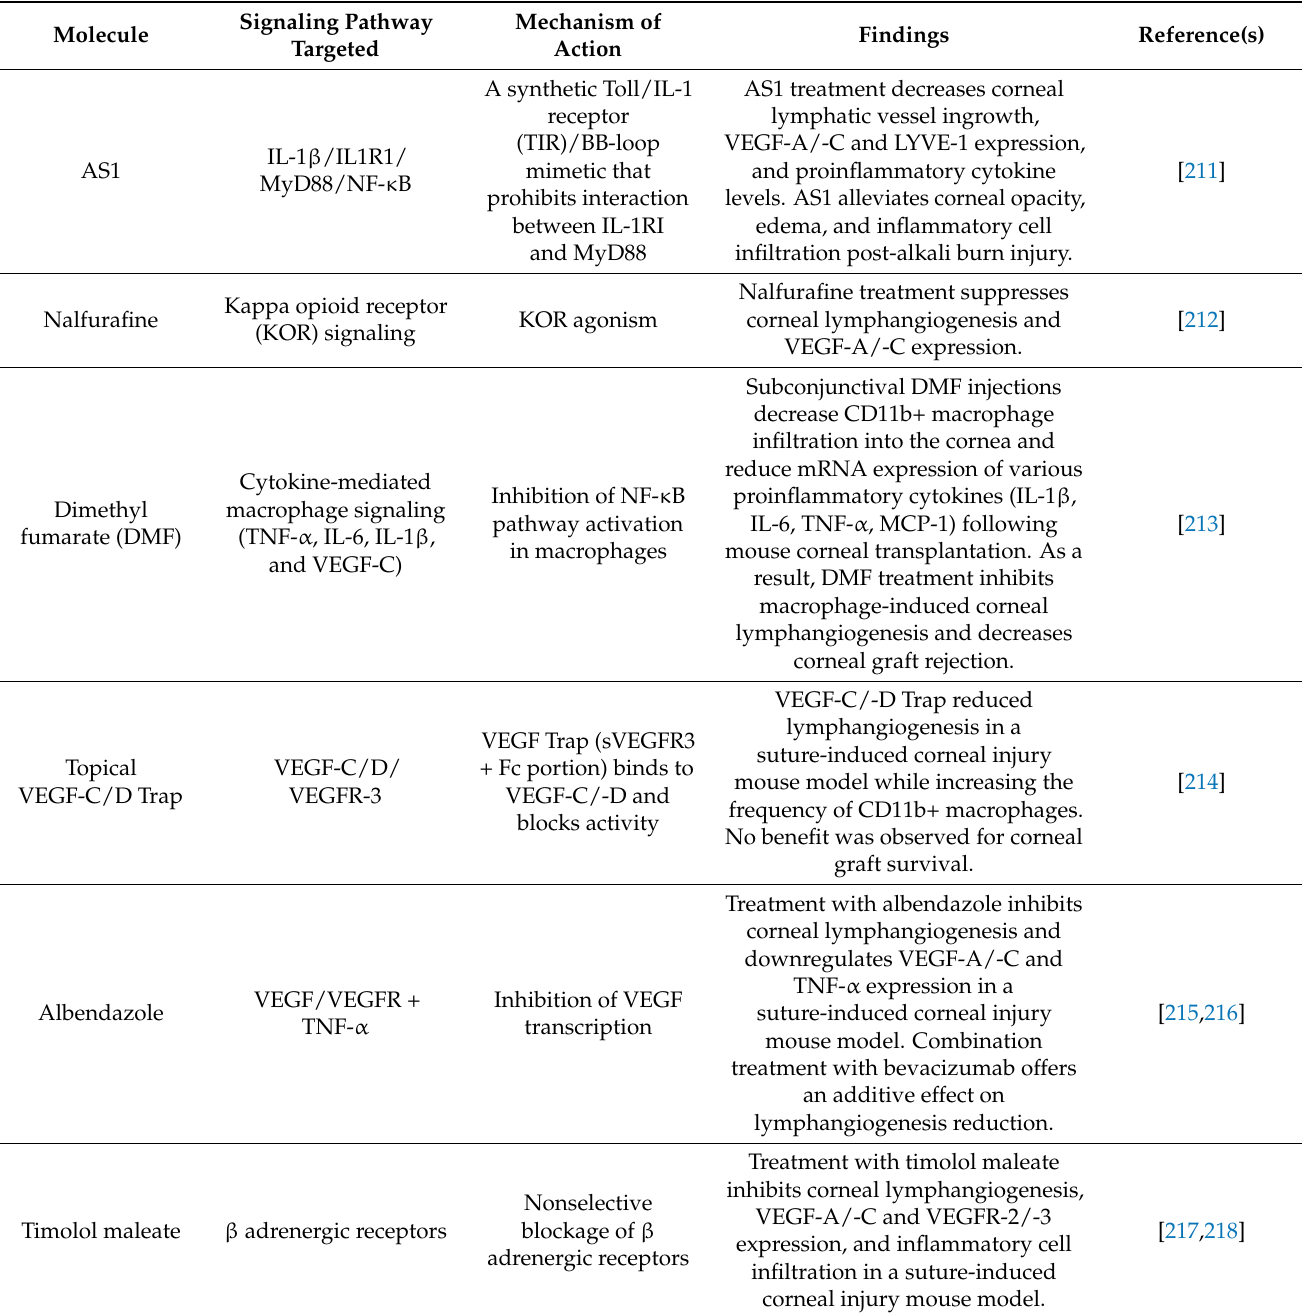
Table 2. Novel exogenous regulators of lymphangiogenesis guidance in the